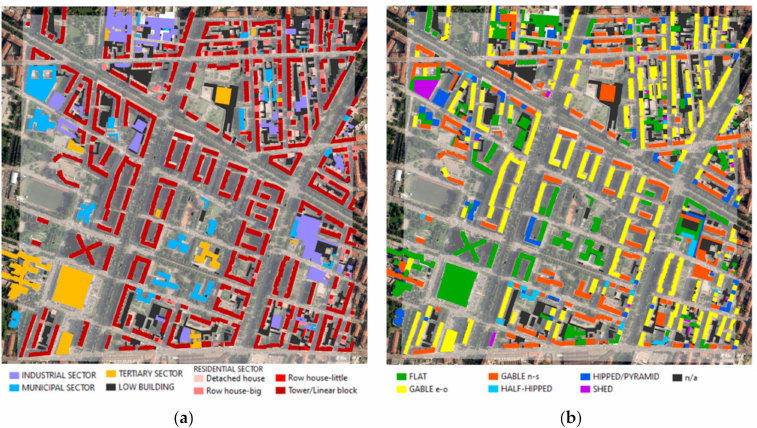
Figure 2. District of Turin with a dimension of 1 km 2 : ( a ) Identification of building typology using type of users, building height, and surface-to-volume ( S / V ) value; ( b ) identification of roof typologies according to [23].